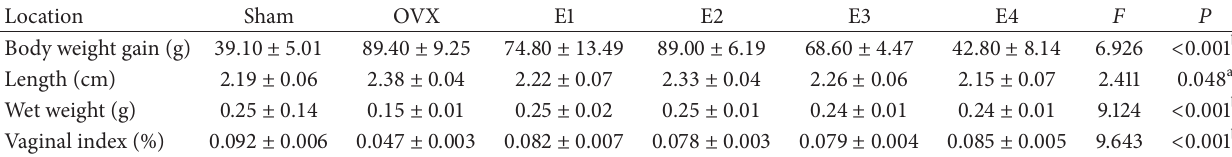
Table 1: Effects of estrogen on vaginal morphologic parameters ( 𝛼 = 0.05 , two-tailed). Location Sham OVX E1 Body weight gain (g) 39.10 ±